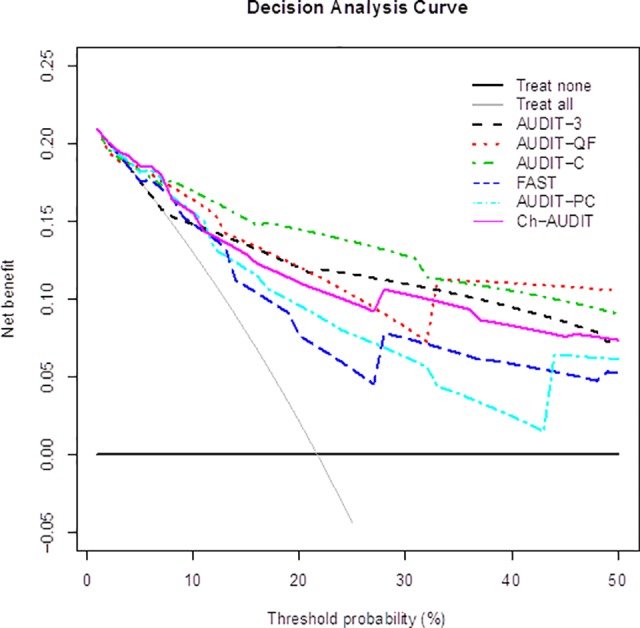
Decision curves showing net benefit in comparisons between various versions of Ch-AUDIT.